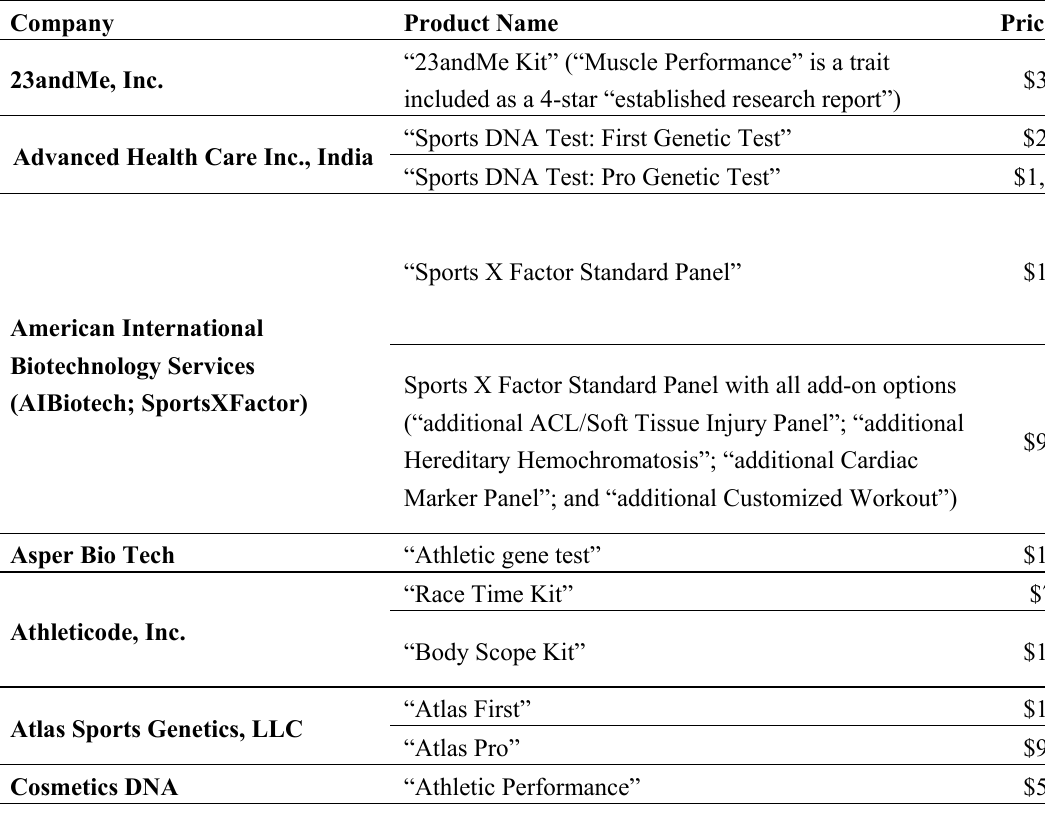
Table 2. Summary of sports-related DNA